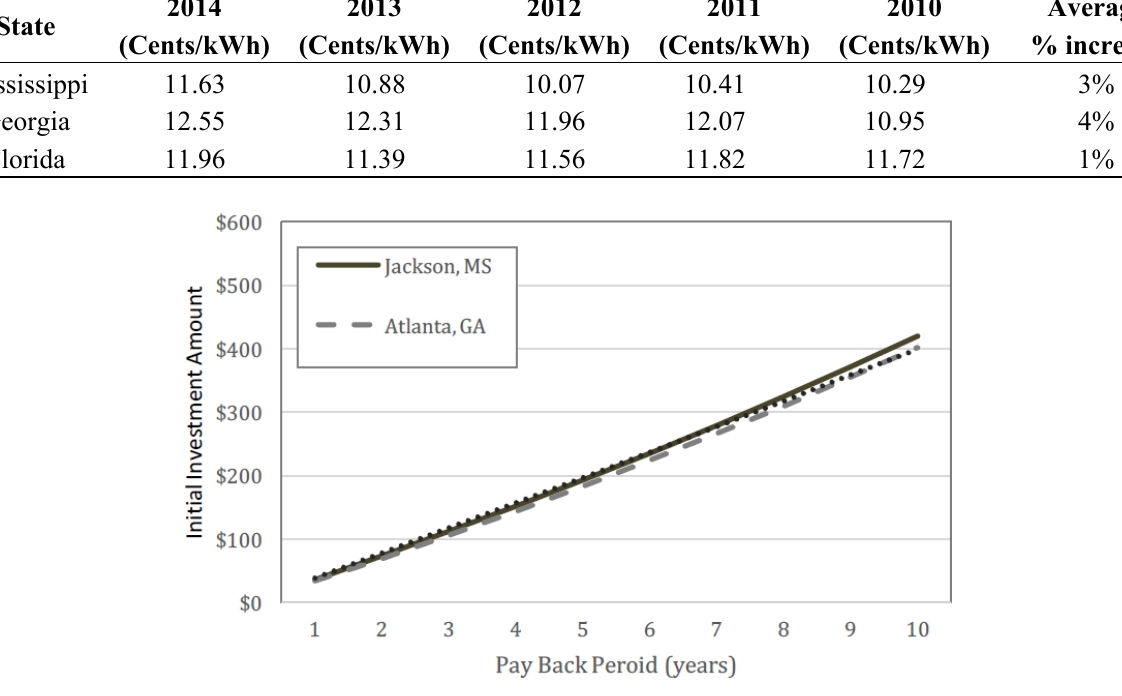
Figure 8. Initial investment amount (USD) per payback